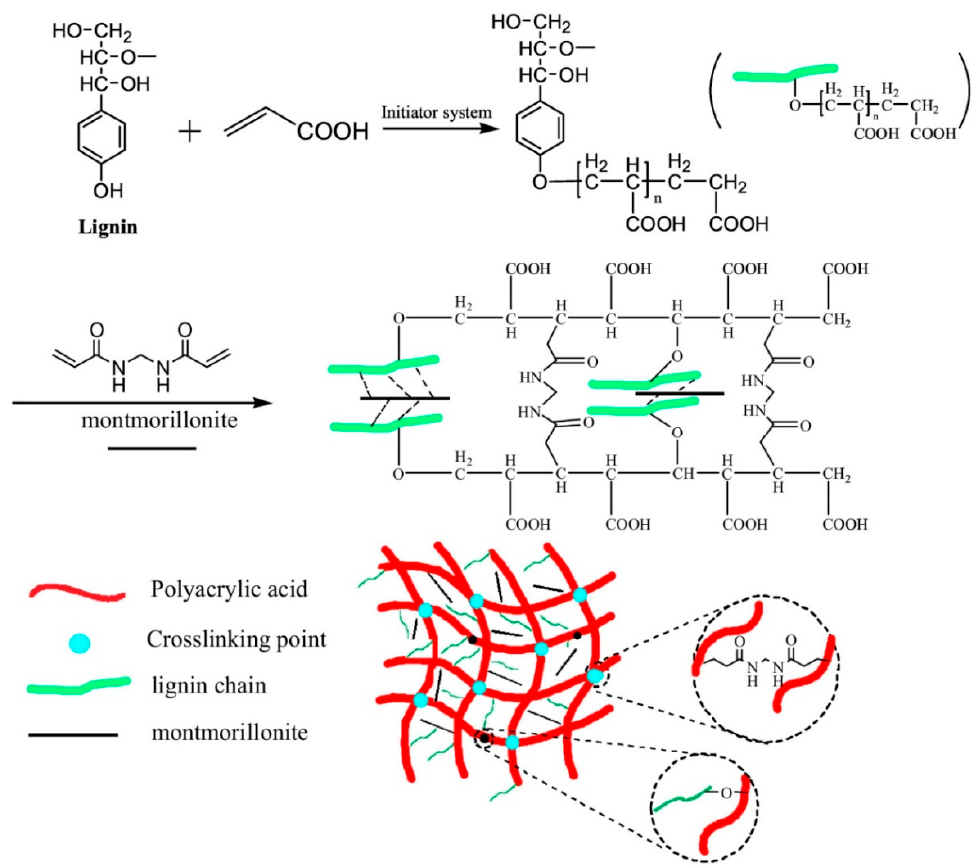
Figure 8. Schematic representation of the synthesis of hybrid hydrogels of lignin/PAA/montmorillonite crosslinked in the presence of NMBA. Reproduced with permission from Sun et al. [58]. Copyright © (2019) Elsevier.